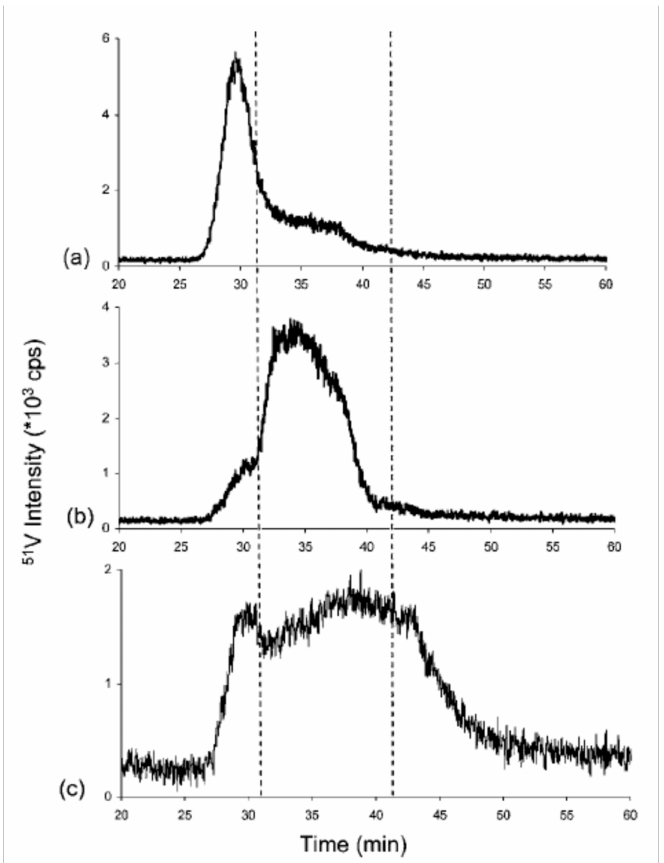
Figure 2. Chromatogramsobtainedbygel-permeationchromatography(GPC)inductivelycoupledplasma (ICP) MS of collected and reinjected ( a ) high-molecular-weight (HMW), ( b ) medium-molecular-weight (MMW), and ( c ) low-molecular-weight (LMW) fractions [47].